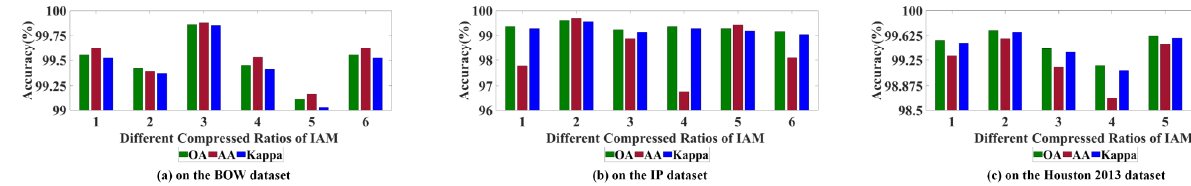
Figure 11. The classification results of diverse compressed ratios.